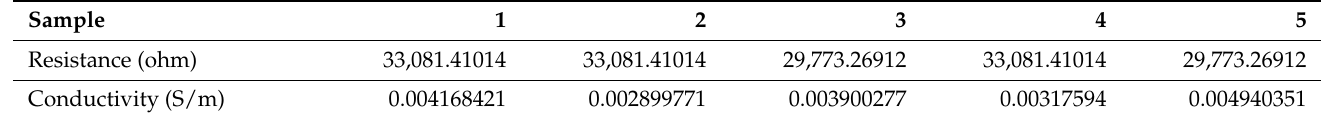
Table A19. Conductivity Data for Nylon 610 Nanocomposites with 3.5 wt% Untreated Graphite Nanosheets.